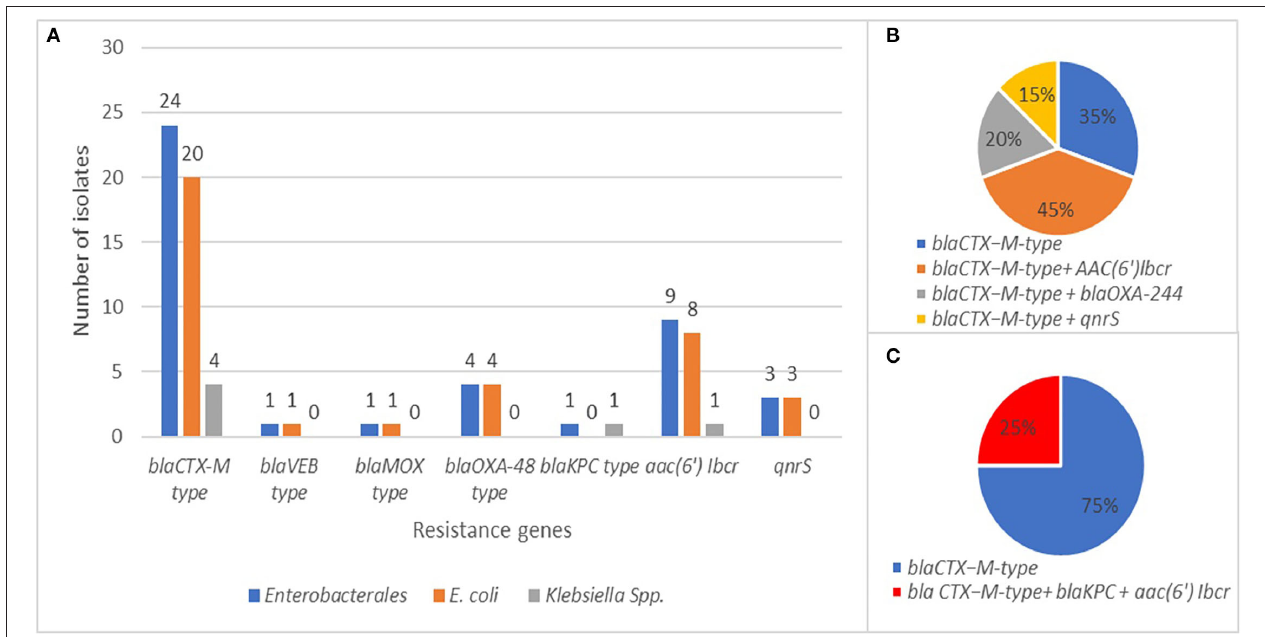
FIGURE 7 | (A) Frequency and distribution of resistance genes in E. coli and K. pneumoniae isolates. (B) Co-occurrence of bla CTX-M with other resistance genes in E. coli isolates. (C) Co-occurrence of bla CTX-M with other resistance genes in K. pneumoniae isolates. coli ; n = 1 K. pneumoniae ), the bla CTX-M-type gene coexisted with other two β -lactamase determinants, bla OXA-244 ( n = 4 E. coli ) ( Figure 7B ) and bla KPC-2 ( n = 1 K. pneumoniae ) ( Figure 7C ). The co-occurrence of bla CTX-M with aac(6 ′ )-Ib- cr or qnrS genes was found in 45 and 15% of Enterobacterales isolates, respectively ( Figure 7 , Table S4 and Table 1 ). One E. coli isolate carried both bla VEB-1 and bla MOX-2 genes, as shown